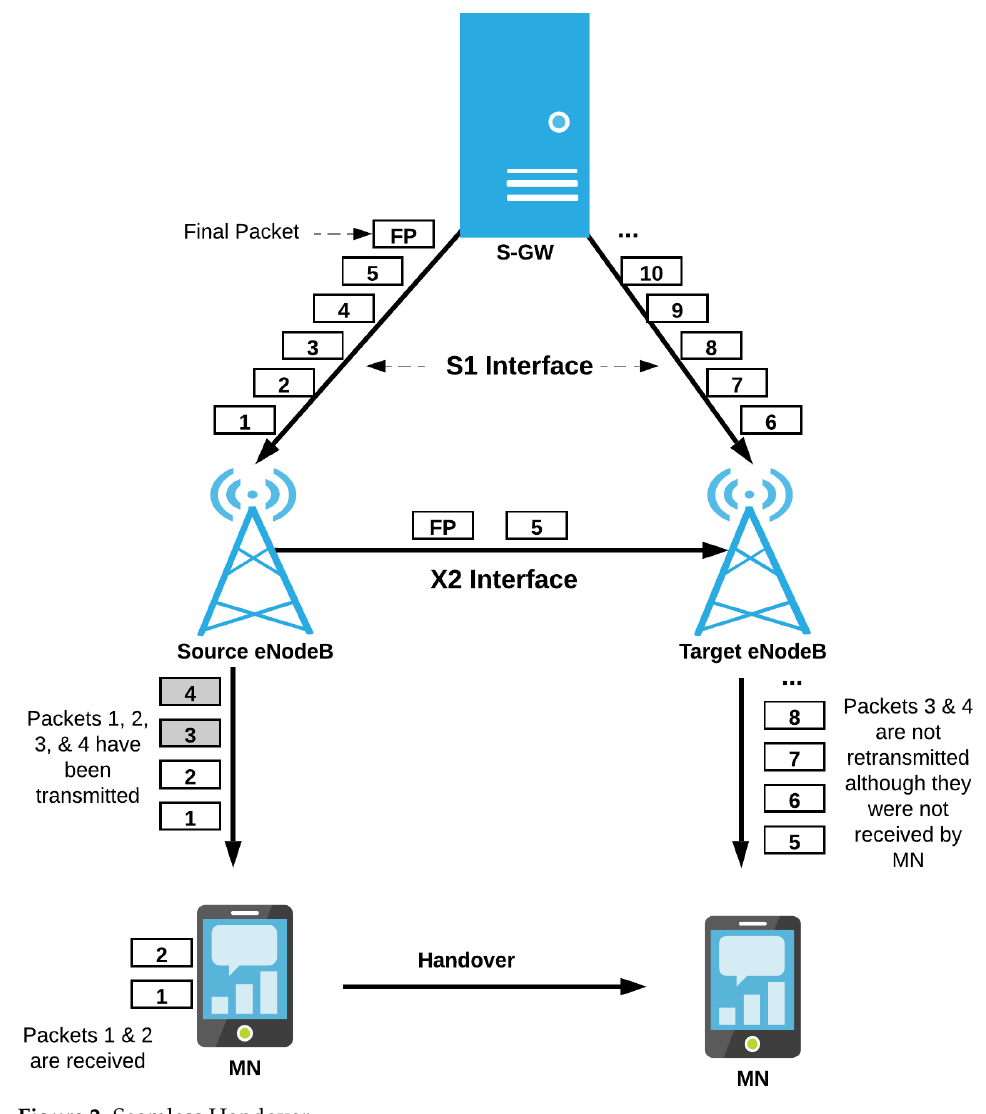
Figure 2. Seamless